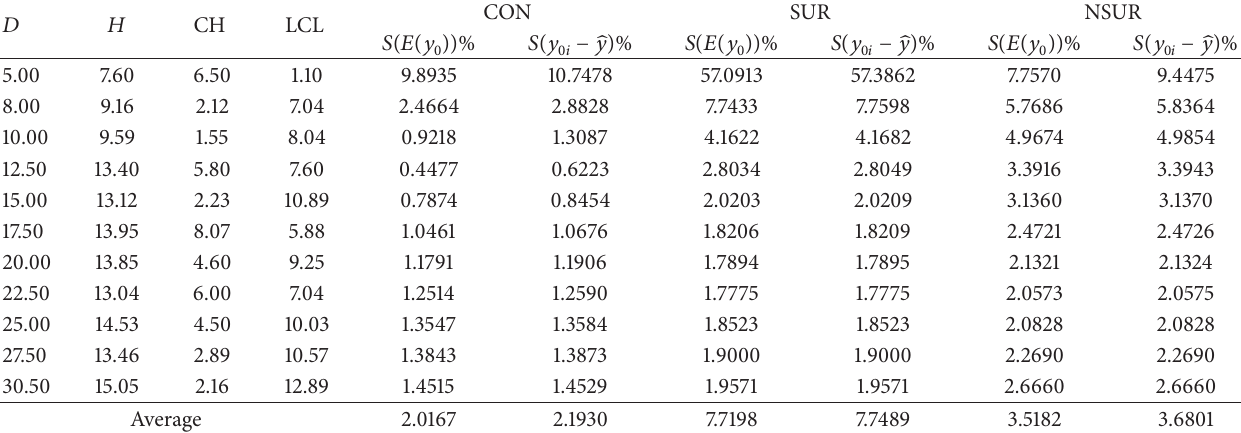
Table 8: Relative standard errors (%) of the expected and predicted total tree biomass values for 11 randomly selected trees. 𝐷 𝐻 CH